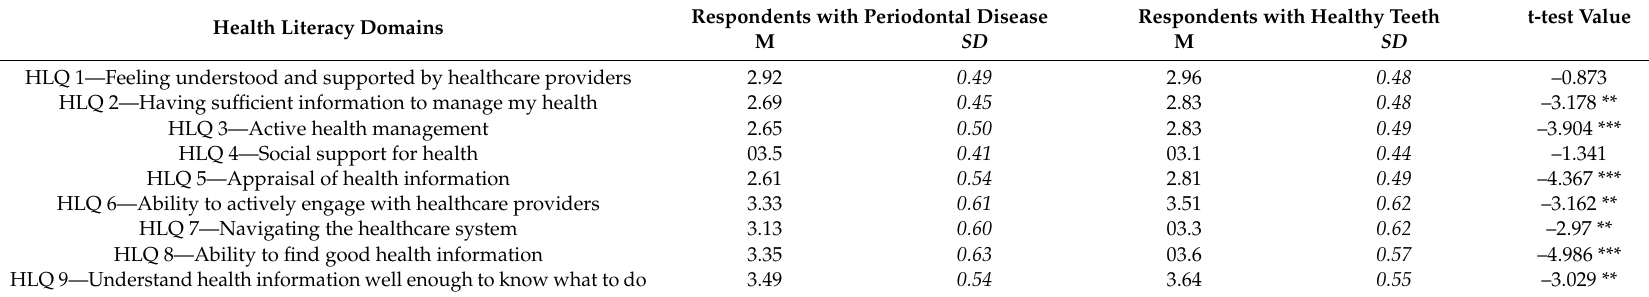
Table 3. Di ff erence in the level of health literacy domains between respondents with gingivitis and respondents with healthy teeth (t-test). Respondents with Periodontal Disease Respondents with Healthy Teeth t-test Health Literacy Domains